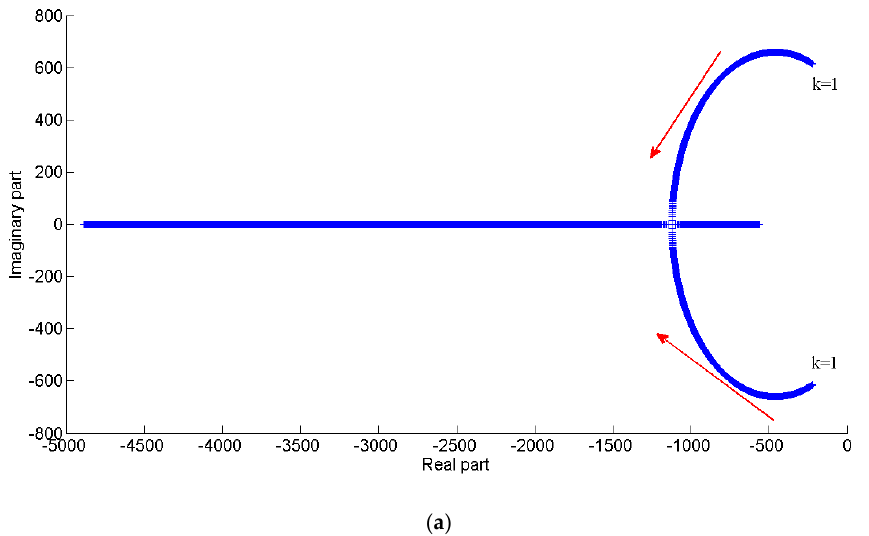
Figure 3. Characteristic equation roots and output voltage of the closed-loop controller for different controller gains. ( a ) Characteristic equation roots during charges of k ( k I = 200); ( b ) characteristic equation roots during charges of k I ( k = 200); and ( c ) step response of proposed PSMC for different values of k I at the start − up